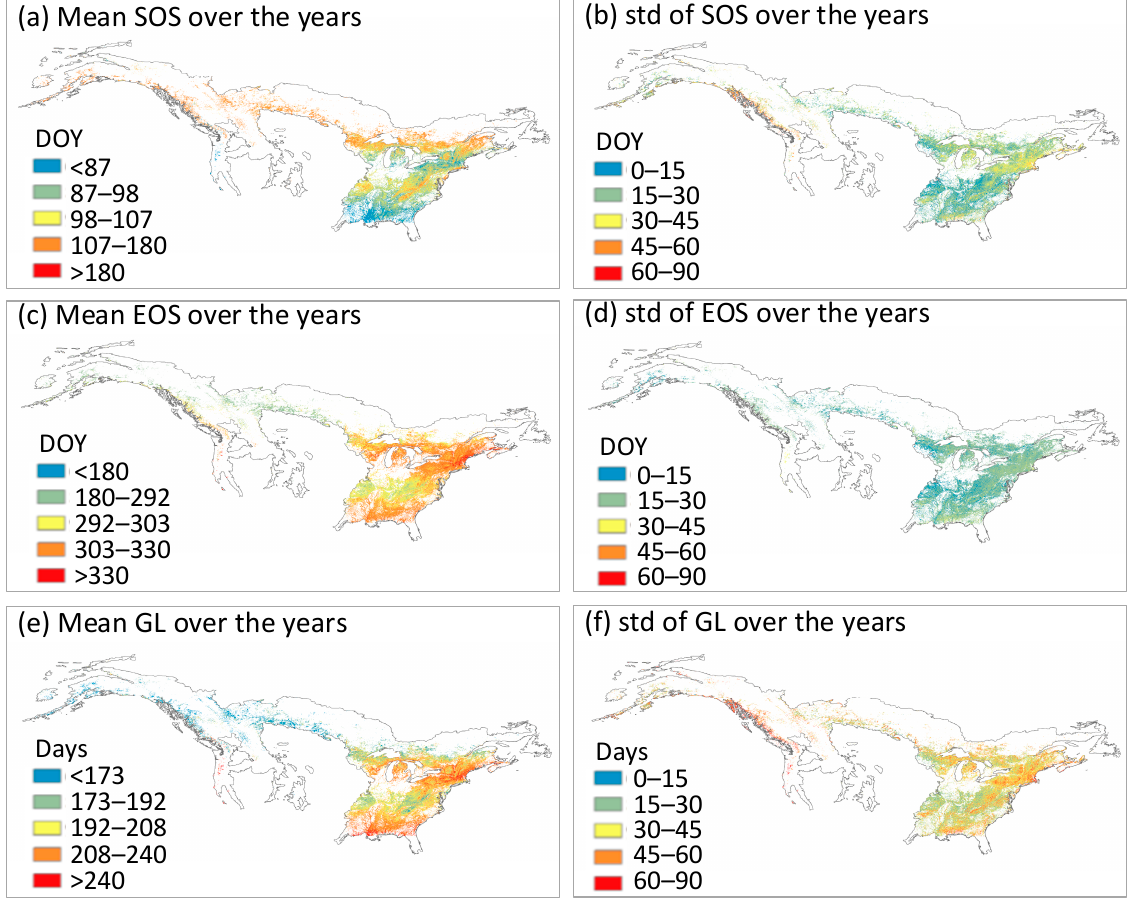
Figure 3. Spatial patterns of the phenological events in the North American deciduous forest from 2001 to 2020. Spatially averaged SOS is 101.61 ± 11.04 ( a ), EOS is 304.26 ± 11.24 ( c ), and GL is 202.17 ± 19.34 ( e ).